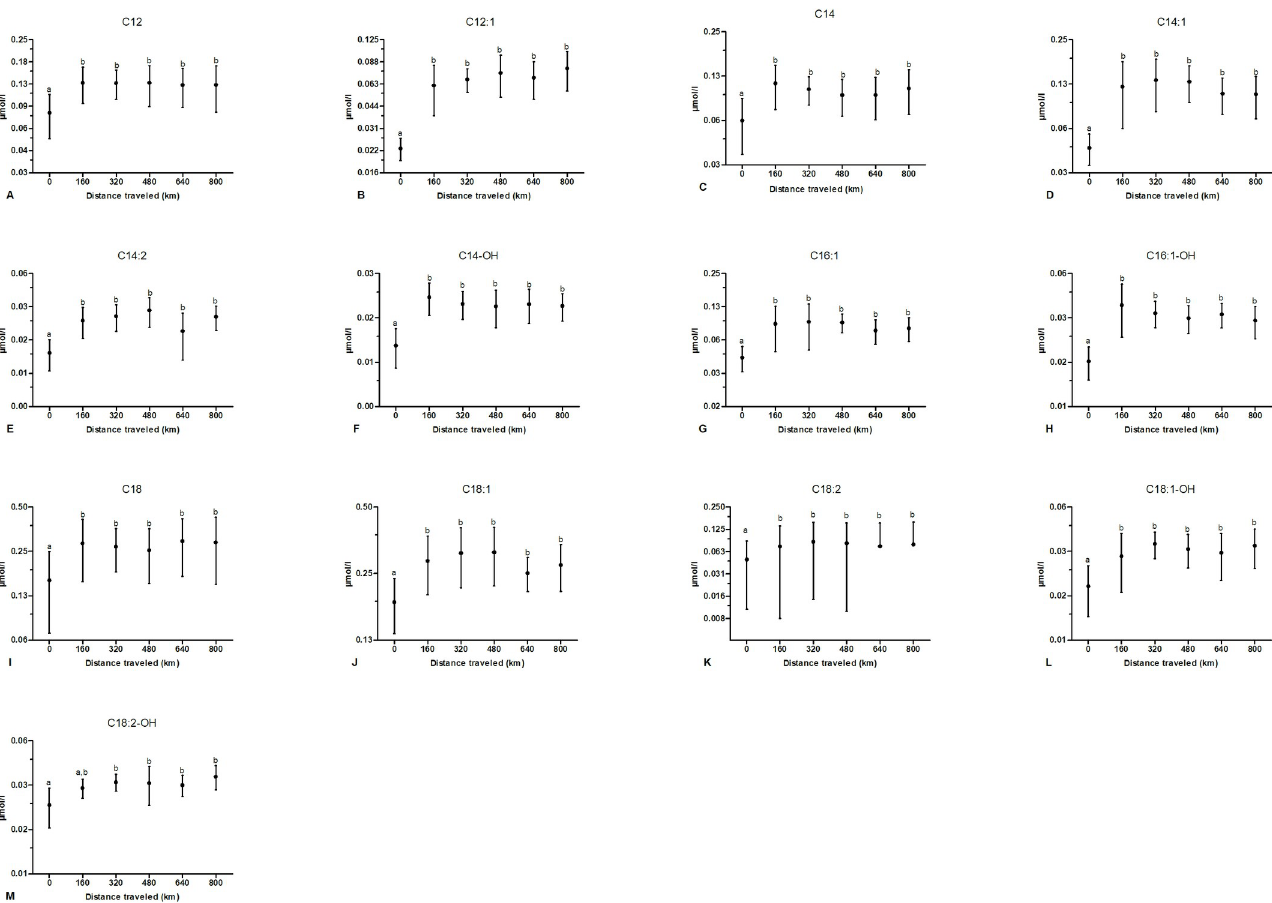
Fig 4. Effect of multiple consecutive days of exercise on plasma long-chain acylcarnitines (LCACs). Samples were obtained from 9 dogs at 0, 160, 320, 480, 640 and 800 km. Data are displayed as raw data (mean ± SD) on a logarithmic axis. Columns with different superscripts (a, b) are significantly different between them ( P < 0.05) and not significantly different from columns with the same superscript. Missing low error bars correspond to negative values that cannot be displayed on a logarithmic axis.